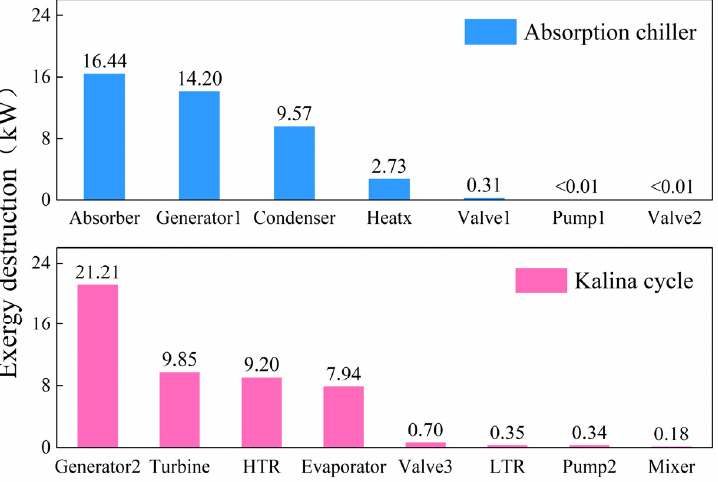
Figure 5. Exergy destruction of each equipment.